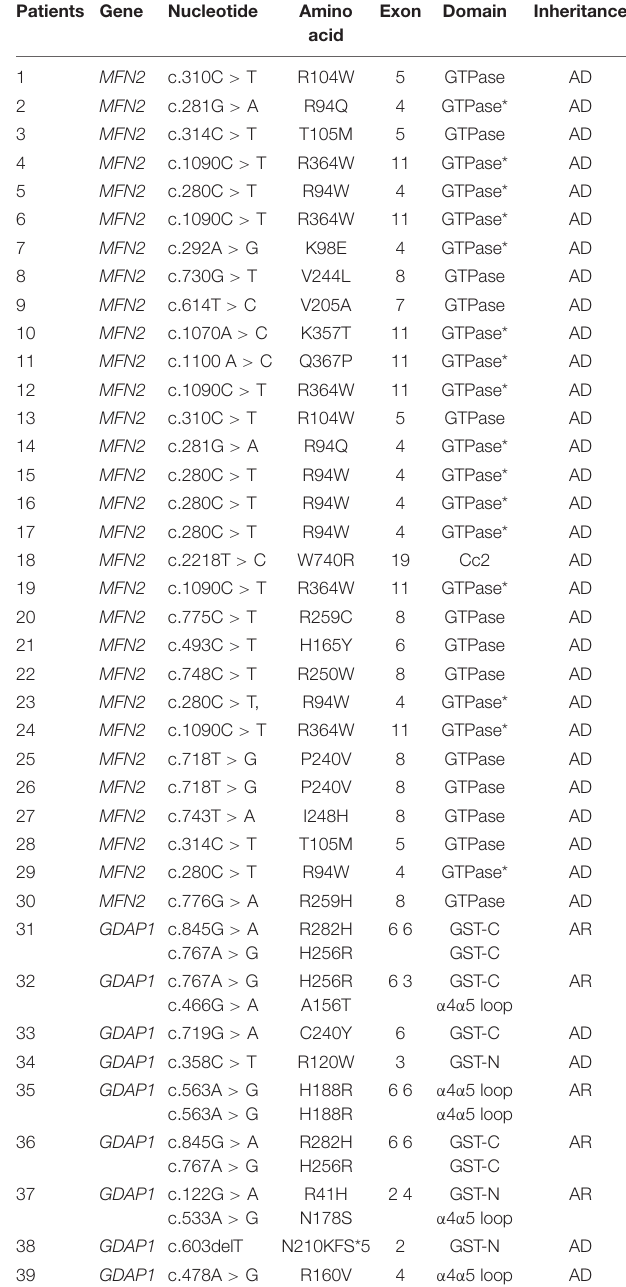
TABLE 4 | Genotype distribution of MFN2 and